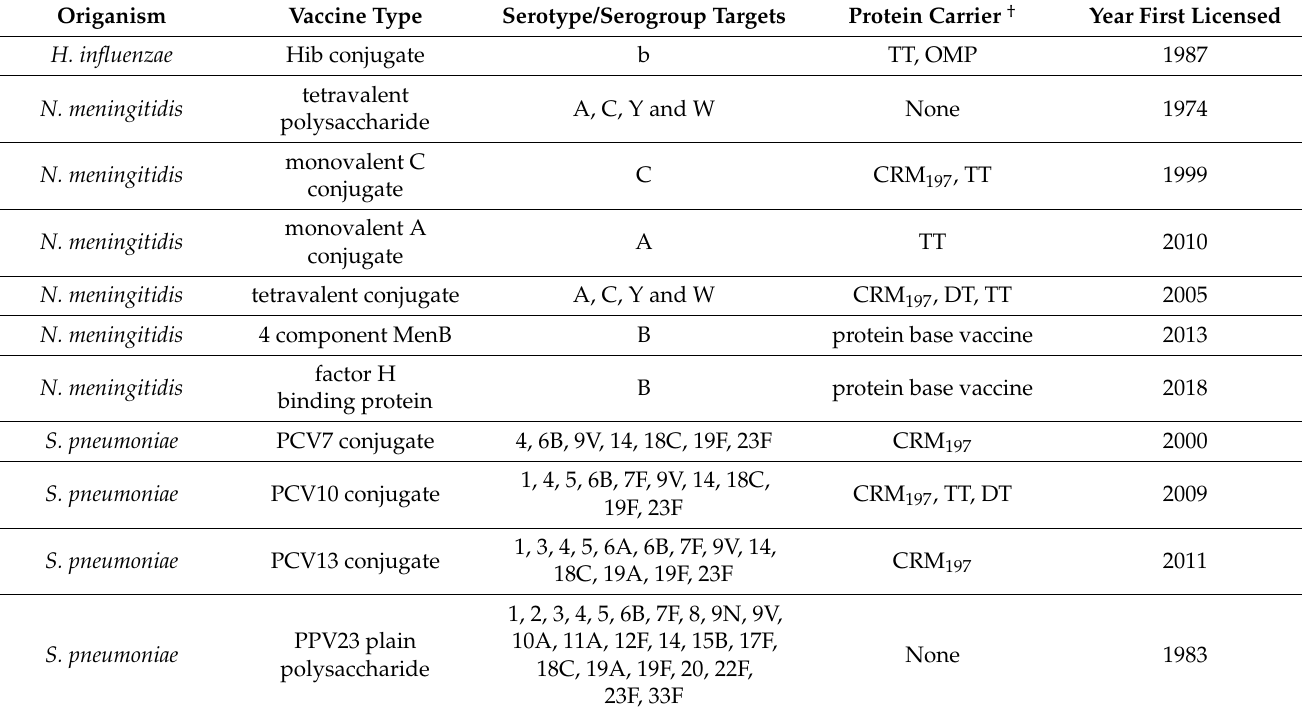
Table 2. Licensed vaccines * against Haemophilus influenzae , Neisseria meningitidis and Streptococcus pneumoniae.